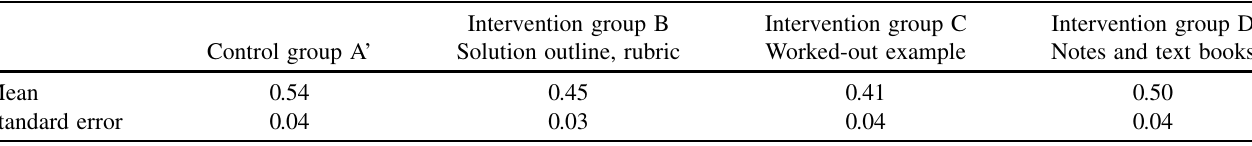
TABLE V. Average physics grades (normalized to 1) for pre (quiz 7) solutions for the different groups.